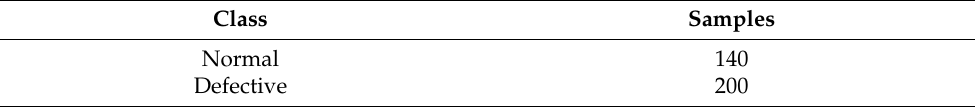
Table 1. Original dataset.